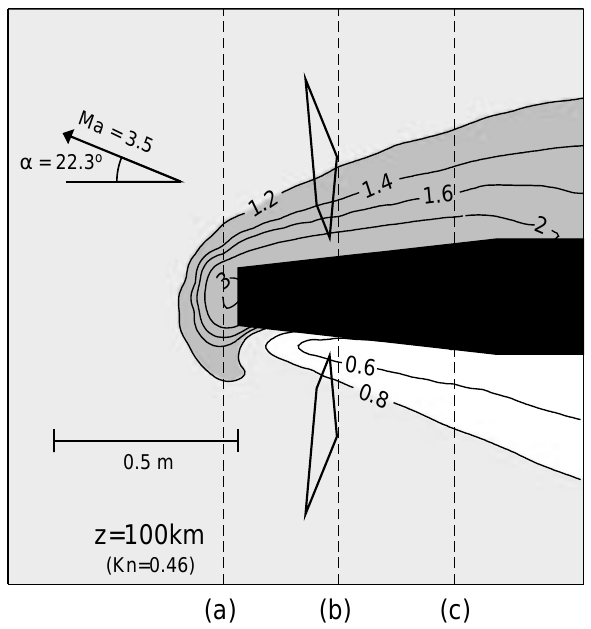
Fig. 4. Calculated relative density field around the rocket at 100-km altitude.